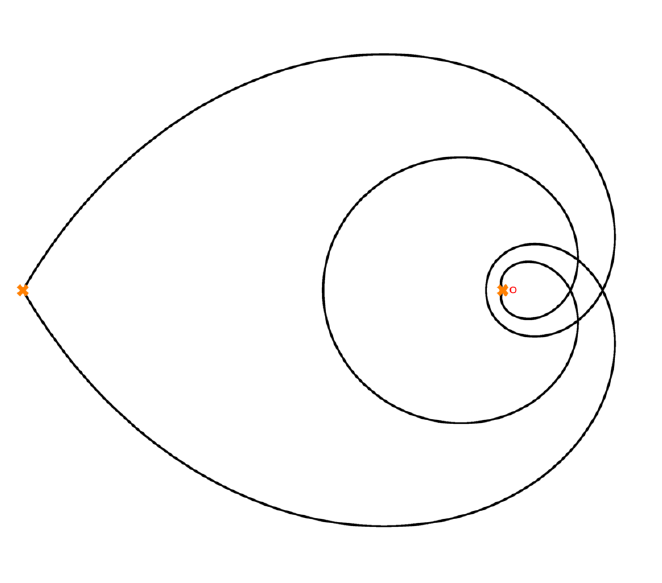
Figure 25. Two (cid:12)xed points for the D0 brane (1 ; 1) at j Q j > 1.